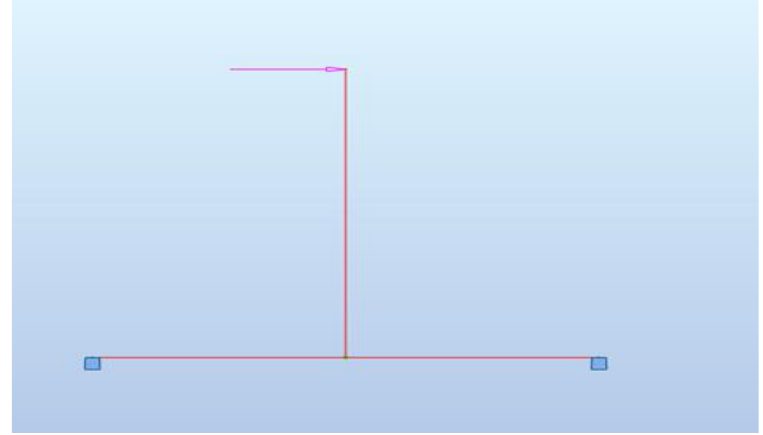
Figure 19. Support and loading condition of the beam-columns assigned in RSA.